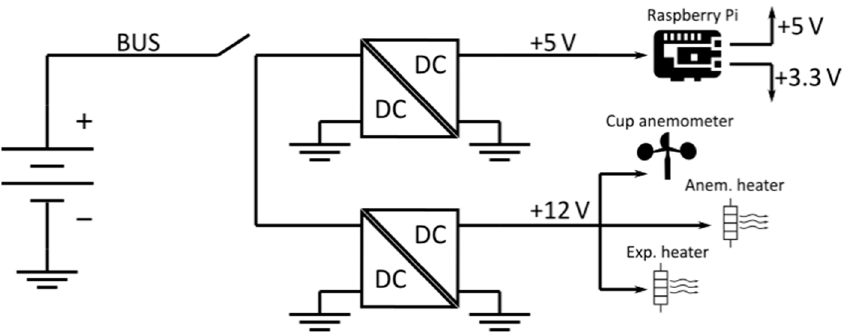
Figure 5. Power subsystem of the TASEC ‐ Lab mission [38].